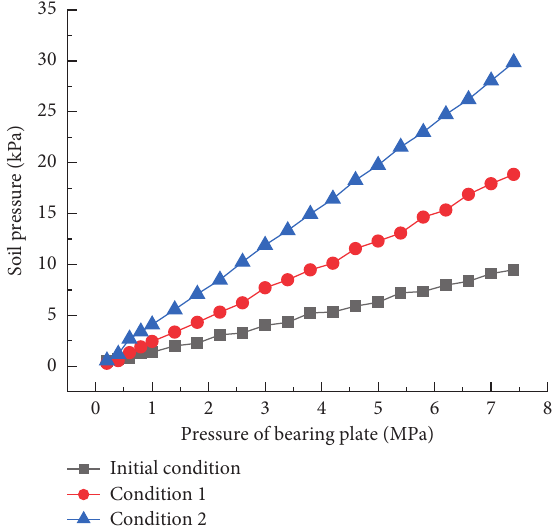
Figure 17: The change of soil pressure with pressure of bearing